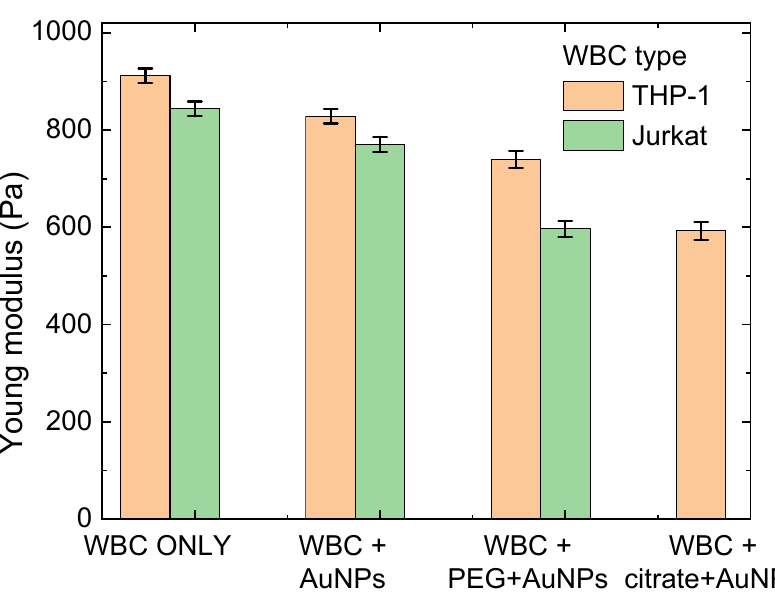
Figure 7. Values of the Young modulus for different experimental cases in this report.